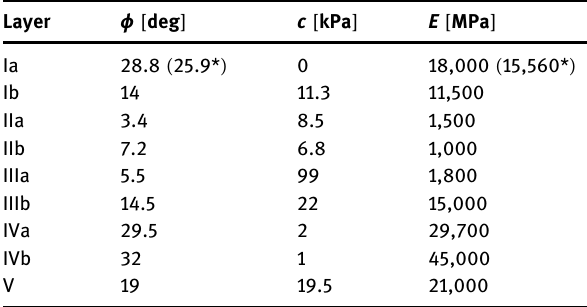
Table 7: Soil parameters used for numerical calculations